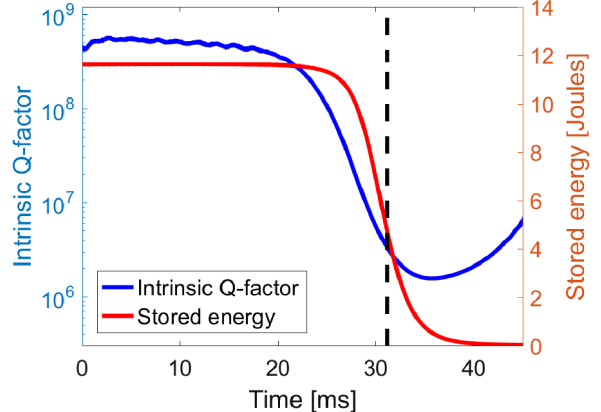
FIG. 2. Intrinsic Q-factor, Q 0 , (blue) and stored energy (red) vs time in the DQW PoP crab cavity during a quench measurement at SM18, CERN. The black dashed line indicates the time of peak power dissipation, P C